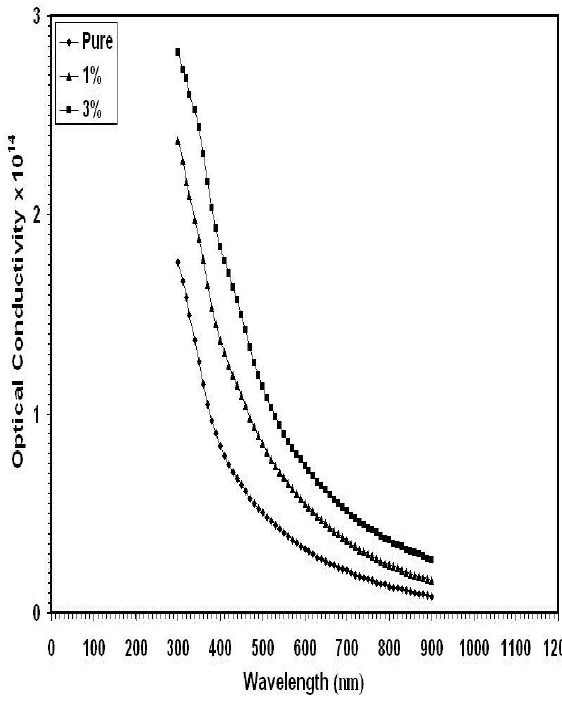
Fig. 3: Optical conductivity versus